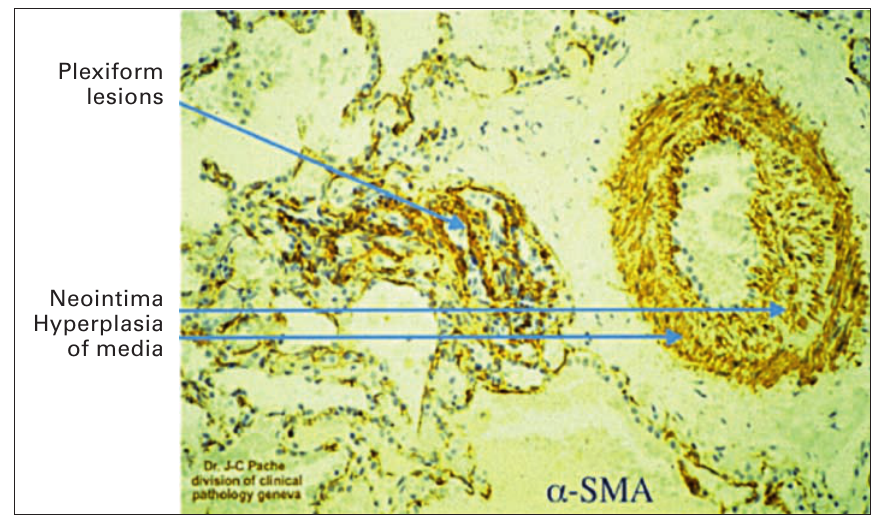
Figure 1 Small lung vessel changes seen in most types of pulmonary hypertension. The hypertrophy of the media and the neo - intima are shown, as well as the plexiform lesions, which consist of small neovessels, arising from the arter-